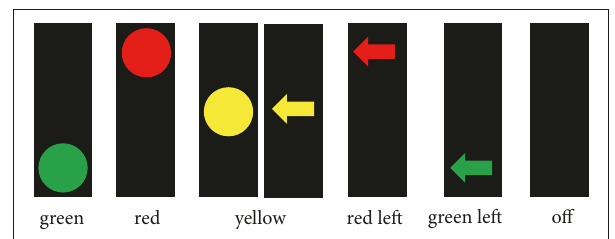
Figure 5: Types of traffic